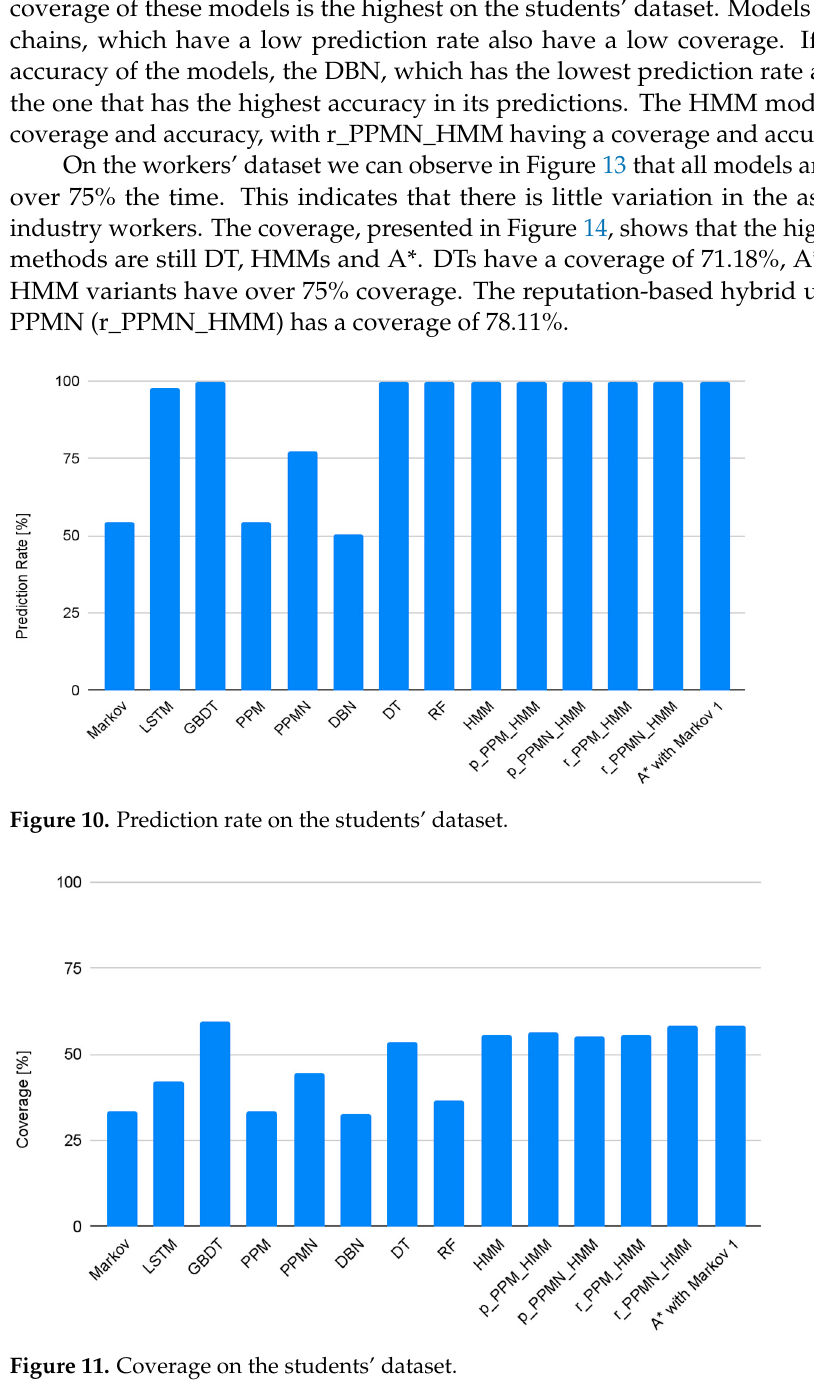
Figure 12. Accuracy on the students’ dataset. Because DT, A*, GBDT, HMM and HMM extensions predict 100% of the time, the coverage of these models is the highest on the students’ dataset. Models such as Markov chains, which have a low prediction rate also have a low coverage. If we look at the accu- racy of the models, the DBN, which has the lowest prediction rate and coverage, is the one that has the highest accuracy in its predictions. The HMM models have a good coverage and accuracy, with r_PPMN_HMM having a coverage and accuracy of 58.22%. On the workers’ dataset we can observe in Figure 13 that all models are able to predict over 75% the time. This indicates that there is little variation in the assemblies of the in- dustry workers. The coverage, presented in Figure 14, shows that the highest performing methods are still DT, HMMs and A*. DTs have a coverage of 71.18%, A* 72.35% and all HMM variants have over 75% coverage. The reputation-based hybrid using HMM and PPMN (r_PPMN_HMM) has a coverage of 78.11%.